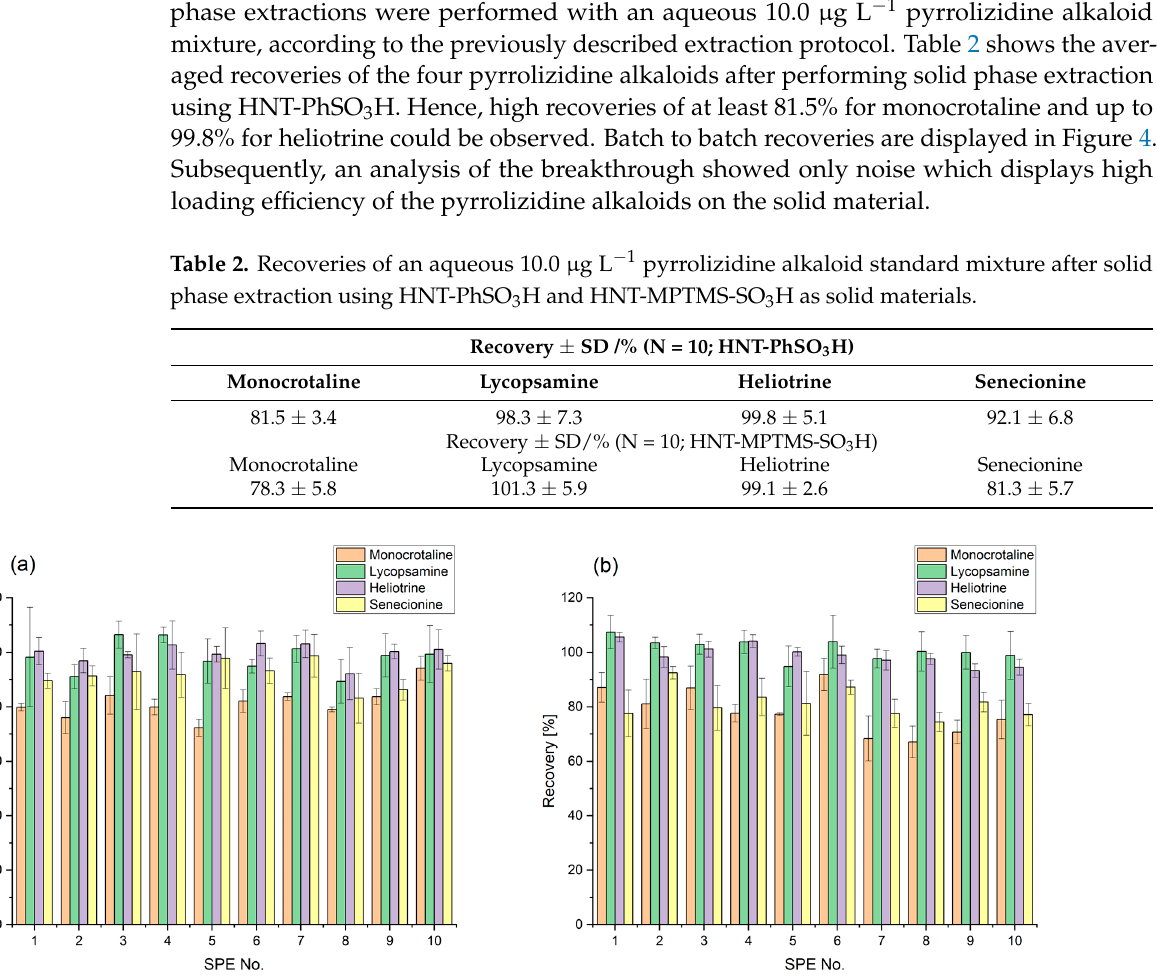
Figure 4. Solid phase extraction of an aqueous 10.0 µ g L − 1 pyrrolizidine alkaloid standard mixture using HNT-PhSO 3 H ( a ) and HNT-MPTMS-SO 3 H ( b ) as solid phase. HNT-MPTMS-SO 3